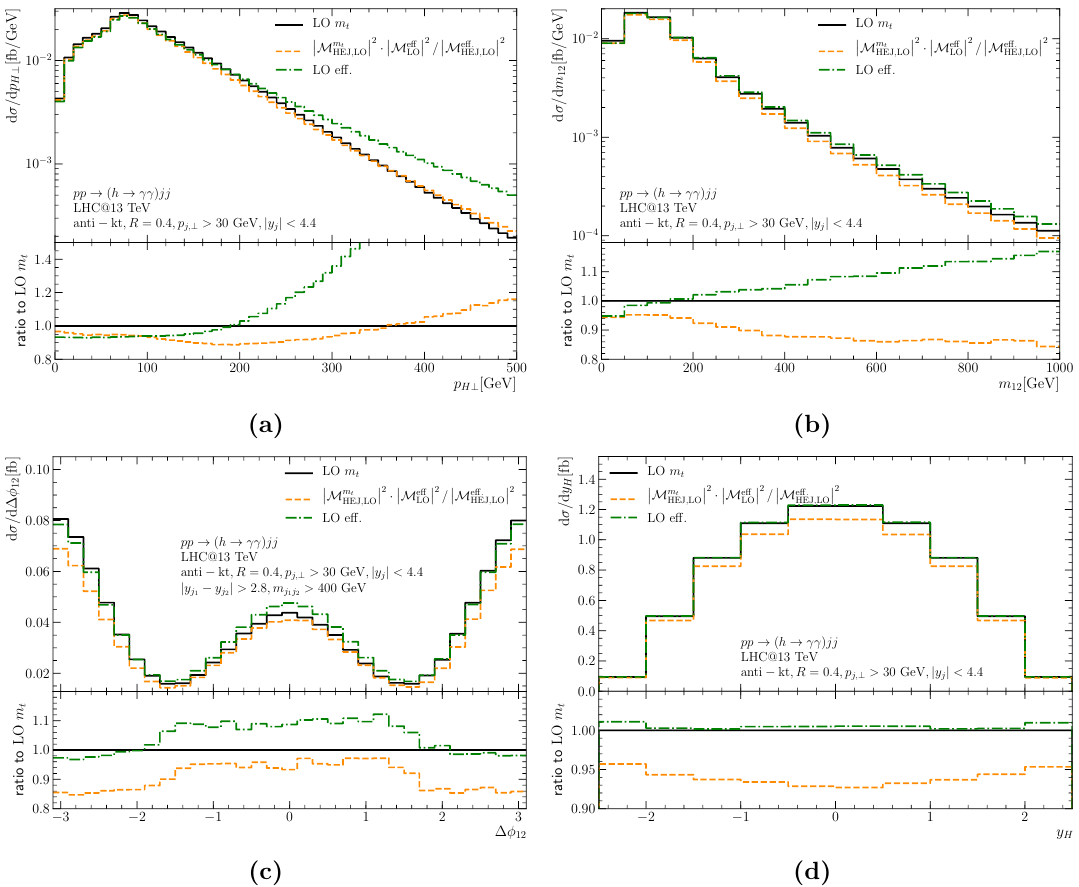
Figure 6 . In these plots we check the quality of reweighting using a ratio of matrix elements with in(cid:12)nite quark mass, using pp H + 2 j where the full result is known. The black solid line shows ! the LO result with full top mass dependence and the green dot-dashed line shows the LO result in the e(cid:11)ective theory. The orange dashed line shows the HEJ result truncated at Born level with full top dependence, reweighted with the ratio of LO to HEJ results in the in(cid:12)nite top-mass limit. The deviation between the orange and black lines arises from the in(cid:12)nite top-mass limit in the reweighting